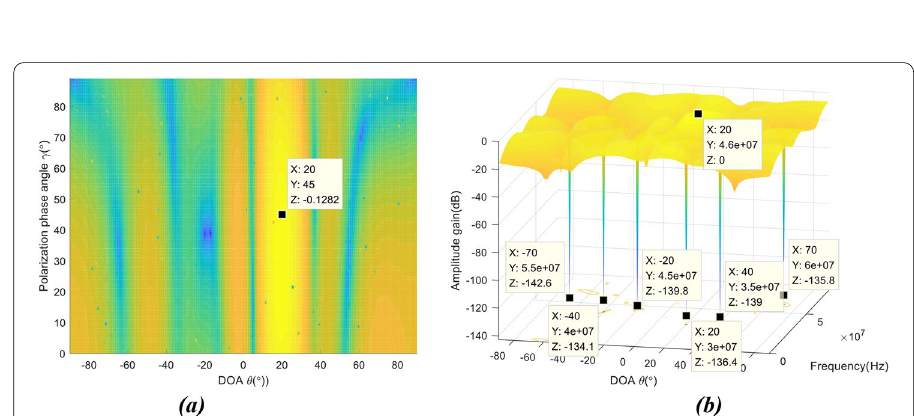
Fig. 8 Three-dimensional beam pattern for the DPSA-STPAP algorithm a space-polarization domain null pattern and b top view of the space–time domain null